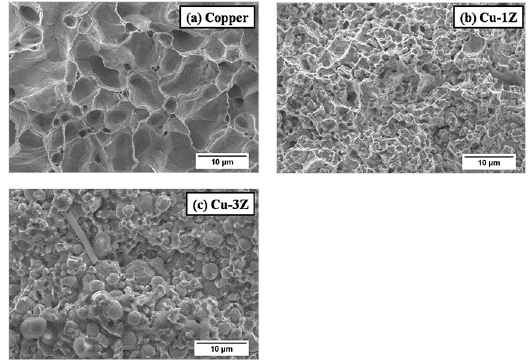
Figure 9. SEM images of the fracture surfaces of Cu, Cu-1Z and Cu-3Z composites sintered at 800 ºC/1 h in Ar/H